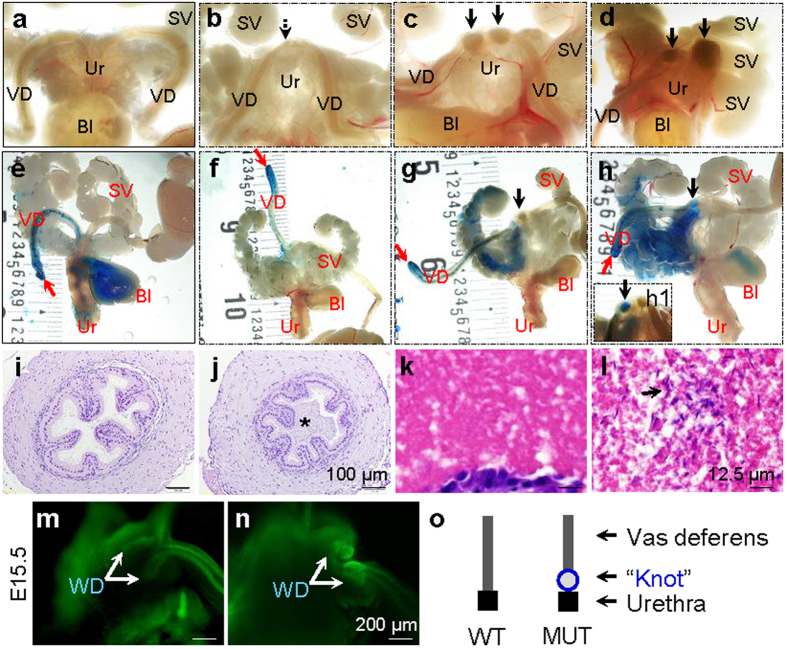
Male distal reproductive tract development.(a–d) Images of WT (a) and MUT (b–d) showing the junctions of vas deferens and urethra. (e) Injection of blue dye via WT vas deferens to indicate a passage to urethra. (f–h1). Injection of blue dye via MUT vas deferens to reveal various blockages to urethra. (h1) An insert in (h) to show blue dye traveling to a “knot” from another fertile MUT male. VD, vas deferens; Ur, urethra; SV, seminal vesicle; Bl, bladder; red arrow, blue dye injection site; dotted black arrow in (b), a less obvious “knot” at the junction of vas deferens and urethra; black arrow in (c,d) and (g-h1), visible “knot” at the junction of vas deferens and urethra. (i) Histology of adult WT vas deferens. (j) Histology of adult MUT vas deferens showing dense sperm in lumen. *Sperm; scale bar (i,j), 100 μm. (k) Histology of adult WT seminal vesicle showing absence of sperm. (l) Histology of adult MUT seminal vesicle showing sperm in the lumen. Black arrow, sperm (blue staining); scale bar (k,l), 12.5 μm. (m,n) PAX2 staining of WT (m) and MUT (n) in E15.5 male embryos. WD, Wolffian duct; scale bar, 200 μm. (o) Summary of phenotypes in male Lhfpl2 MUT distal reproductive tract. Blue circle, a visible “knot” with distal vas deferens convolution; not shown, seminal vesicle abnormalities in 32% MUT males.